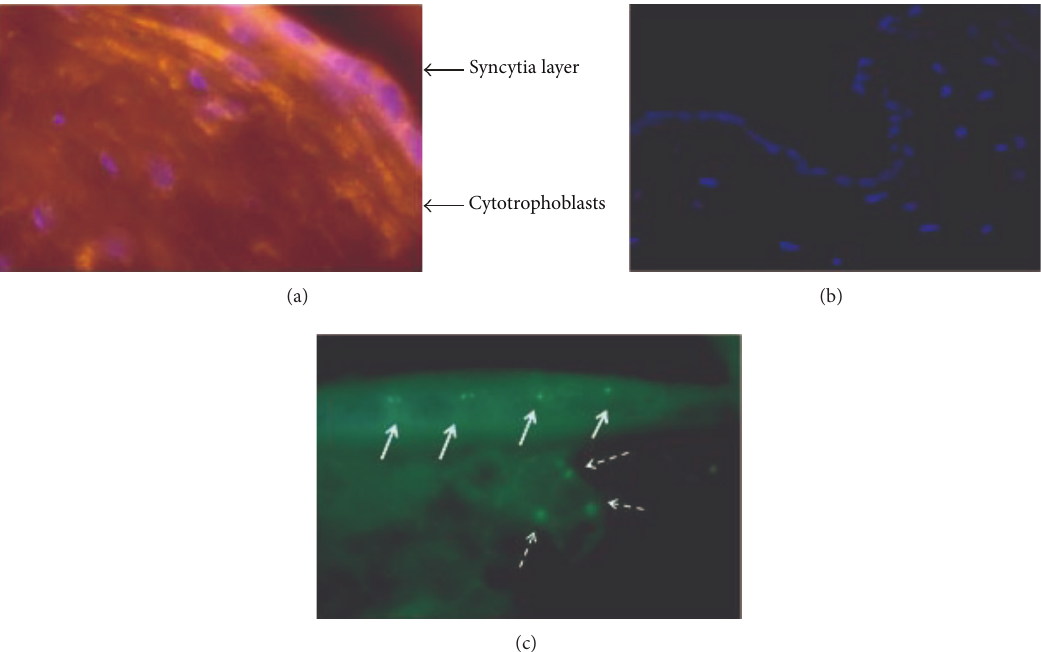
Figure 2: (a) Immunofluorescent analysis demonstrated expression of GR 𝛼 primarily in the syncytiotrophoblastic layer of term placentas. (b) Negative control, confirmed specificity of immunostaining. (c) RNA FISH confirmed expression of GAS5 in cytotrophoblasts cells (dotted arrows) and syncytiotrophoblasts cells (white